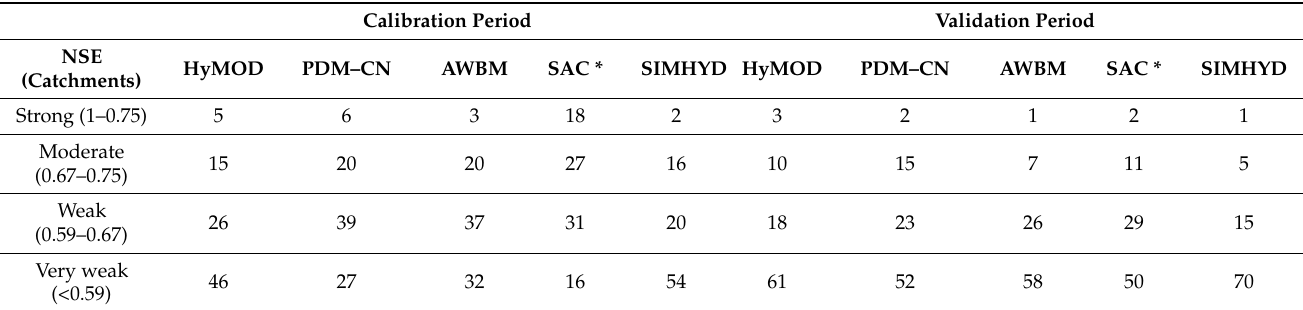
Categories of Nash–Sutcliffe efficiency (NSE) for catchments in calibration and validation